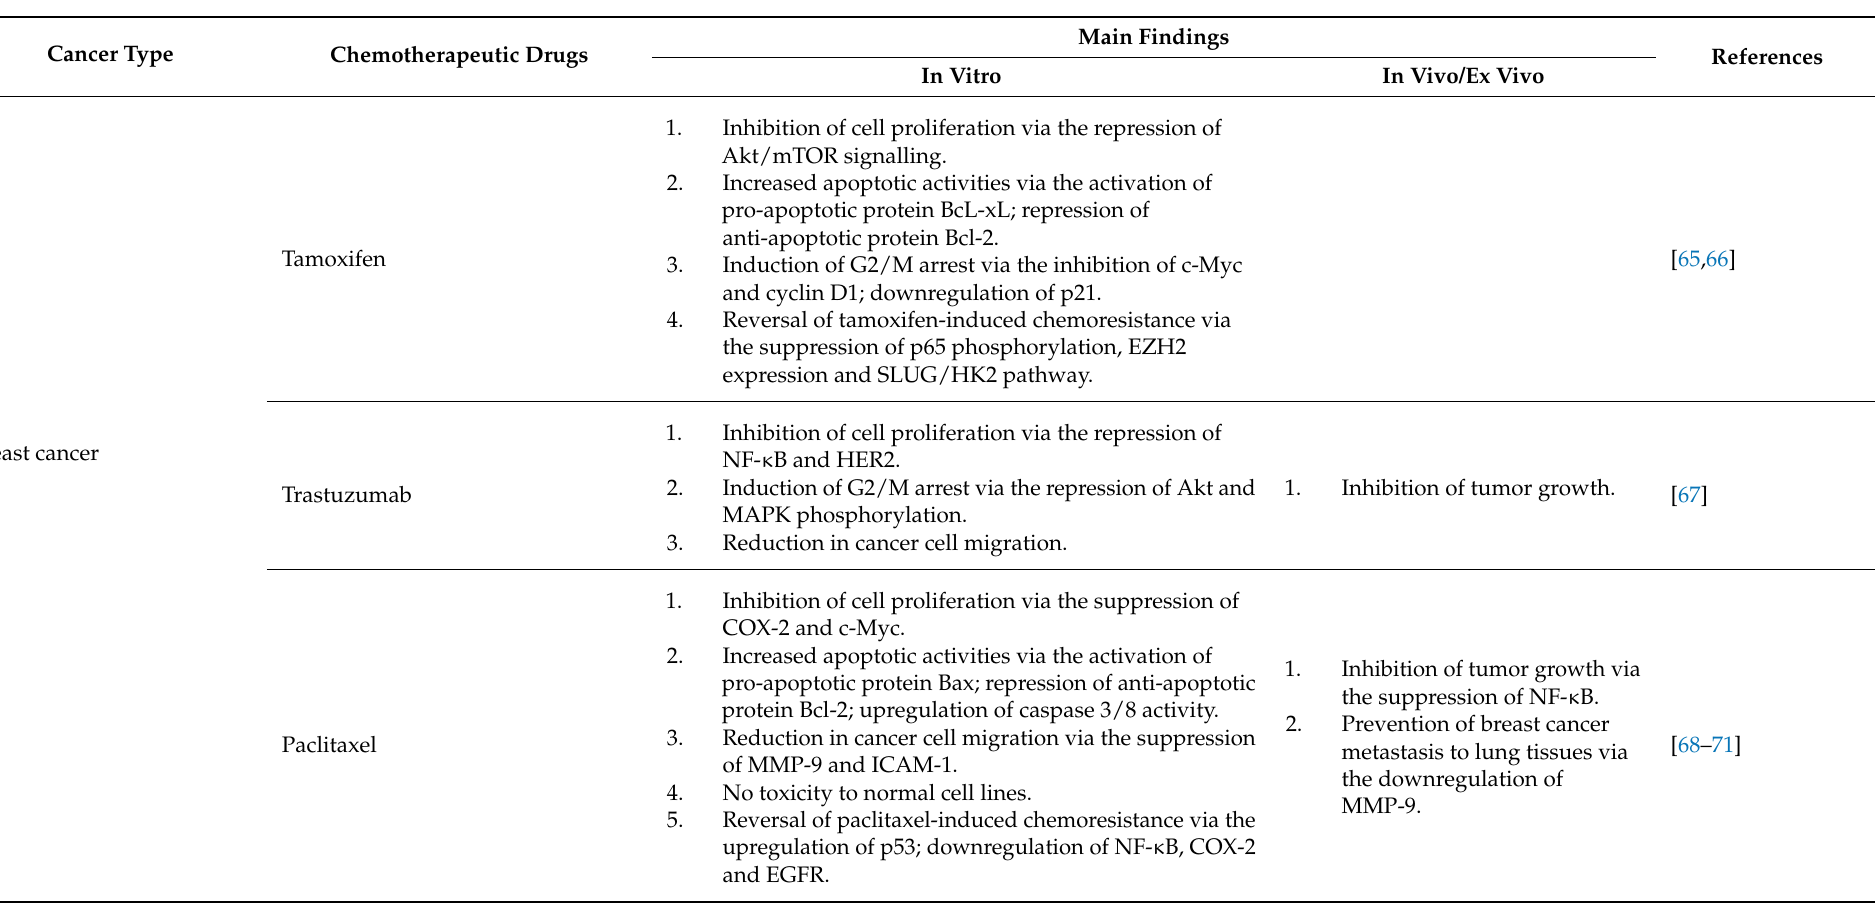
Table 1. Preclinical findings of curcumin combination therapy in enhancing anticancer effects. The findings were summarized in the studies of cell line (in vitro), animal (in vivo) and tissues/organs experimentation under more controlled condition (ex